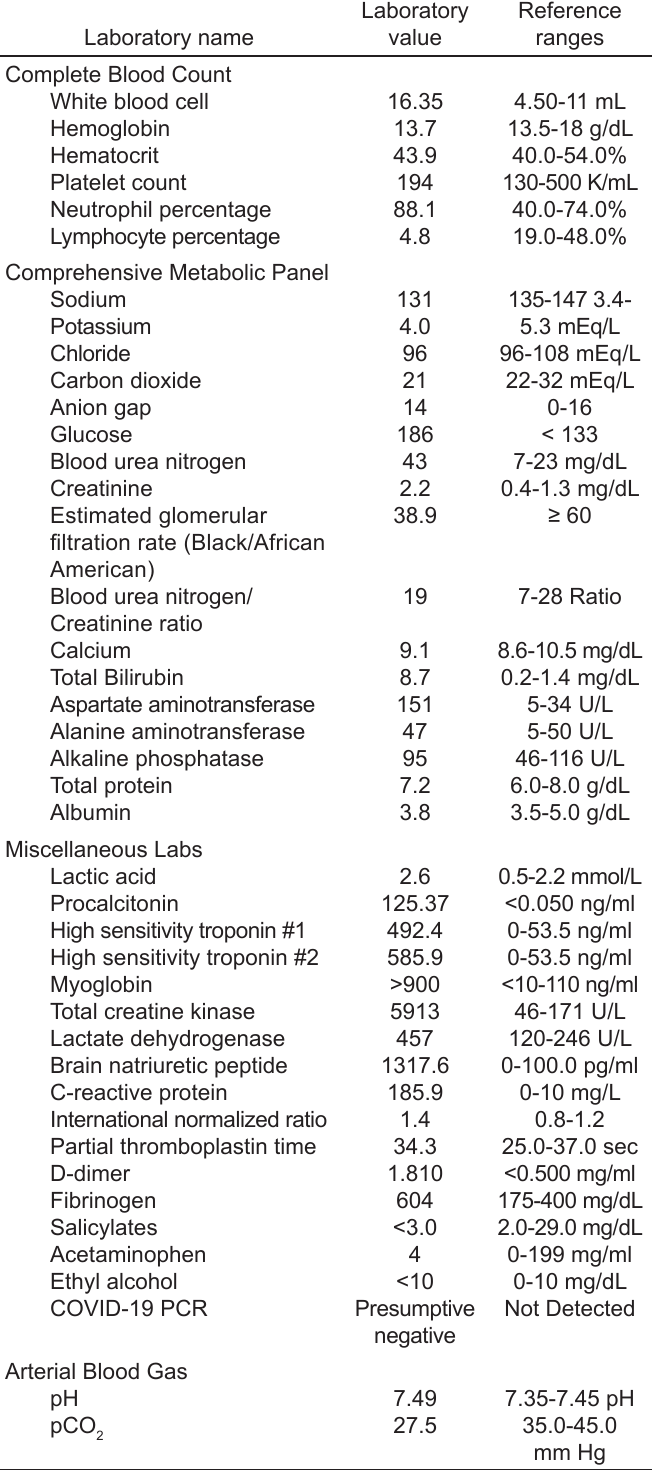
Table 1. Laboratory values of a 48-year-old male with respiratory distress and altered mental